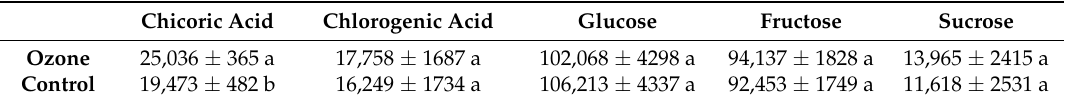
Table 3. Effect of ozone treatment on main phenolic acids and sugars (mg kg –1 dw) in Radicchio rosso di Treviso